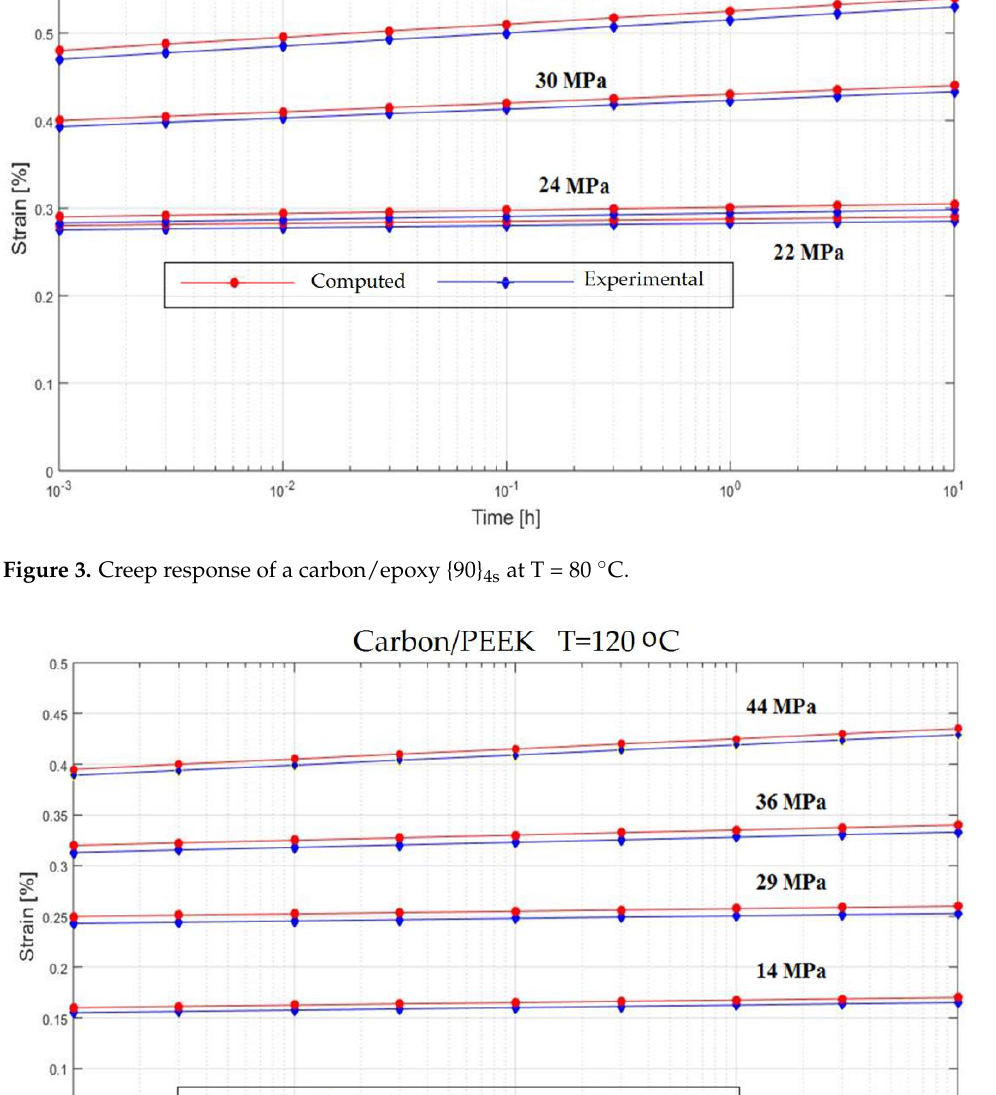
Figure 2. Creep response of a carbon/epoxy {90} 4s at T = 23 ° C.